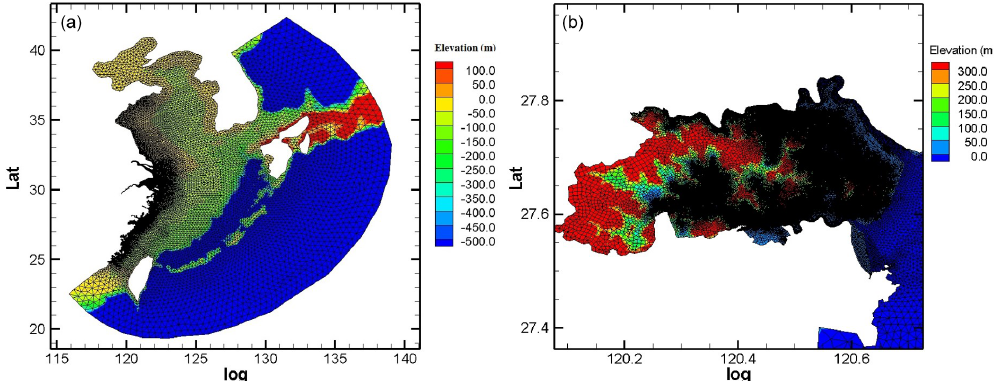
Figure 3. (a) Computational domain of the numerical model in the offshore area and (b) refined mesh in Pingyang